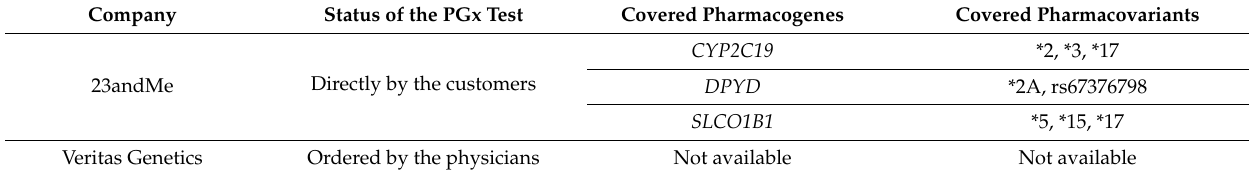
Table 1. List of direct-to-consumer genetic tests DTC-GT companies offering pharmacogenomic PGx tests. Company Status of the PGx Test Covered Pharmacogenes Covered Pharmacovariants 23andMe Directly by the customers Veritas Genetics